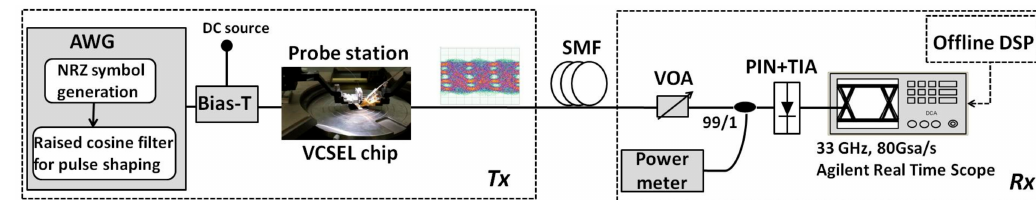
Figure 4. The experimental setup used for the high-speed single-mode VCSEL experiment.